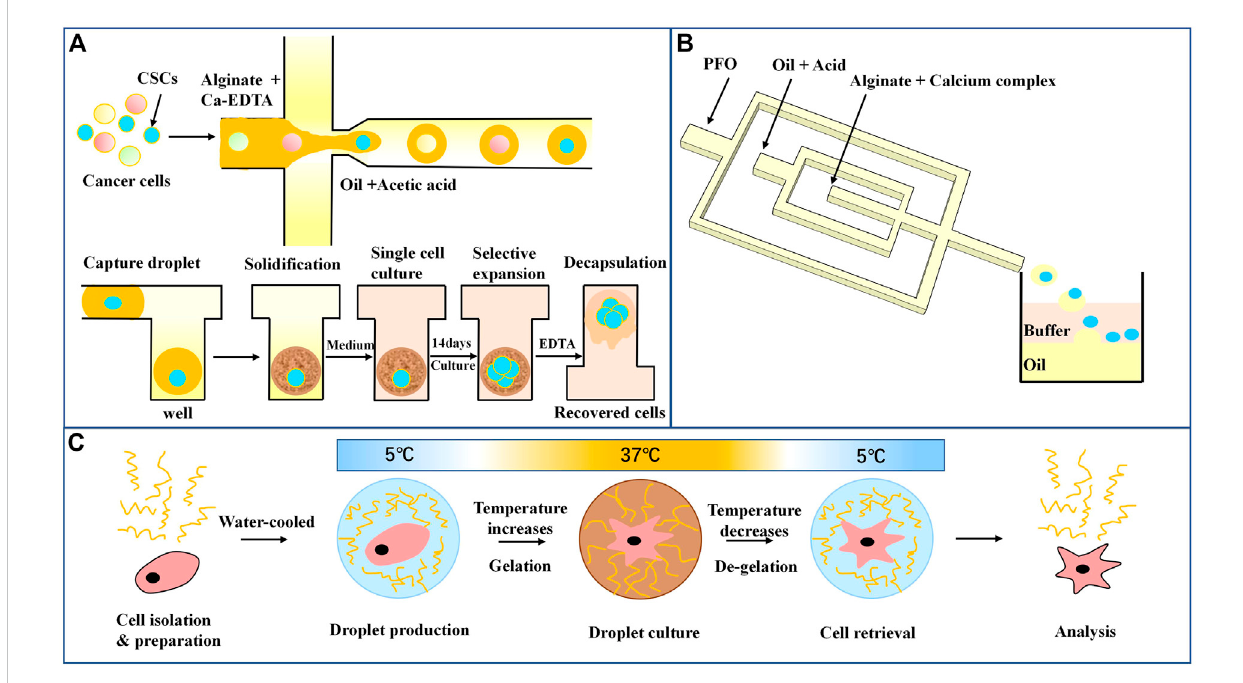
FIGURE 4 Droplet micro fl uidics for single-cell culture (A) Schematic diagram of sodium alginate droplet arrays for cancer stem cell culture and screening (Lin et al., 2021). (B) Micro fl uidic encapsulation of single cells by alginate microgels using a trigger-gelation strategy. Nitrilotriacetic acid (NTA) complex alginate drops were demulsi fi ed in a neutral pH environment (Shao et al., 2020). (C) In the hydrogel and cell encapsulation work fl ow, cells (red) are encapsulated with hydrogel (blue) at 5 ° C; as temperature increases in the cell incubator, gelation occurs, and after the desired culture period, droplets are cooled followed by de-emulsi fi cation, resulting in easy cell retrieval (Tiemeijer et al.,